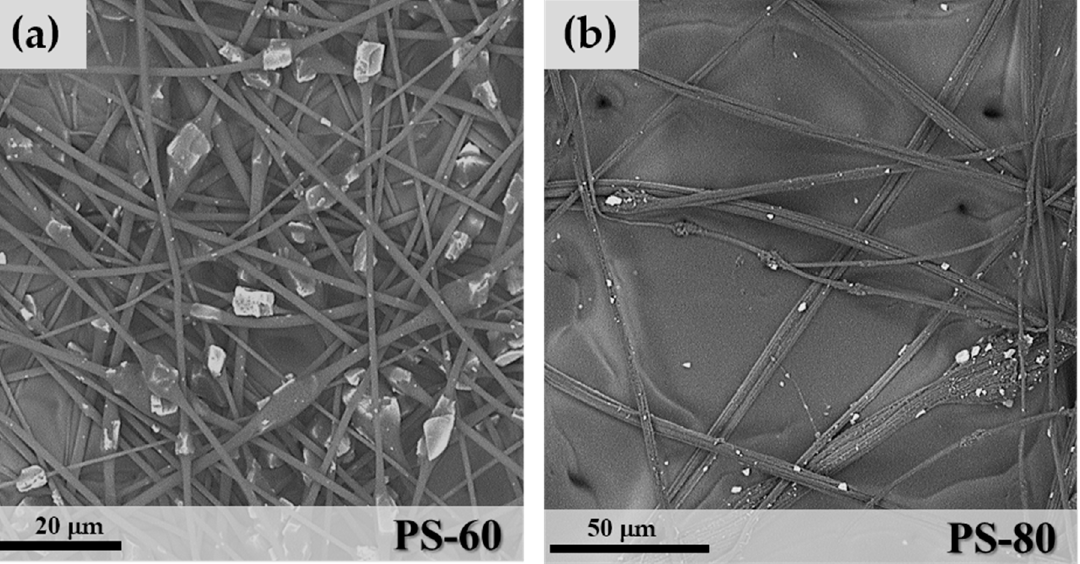
Figure 9. SEM images of PS-60 ( a ) and PS-80 ( b ).